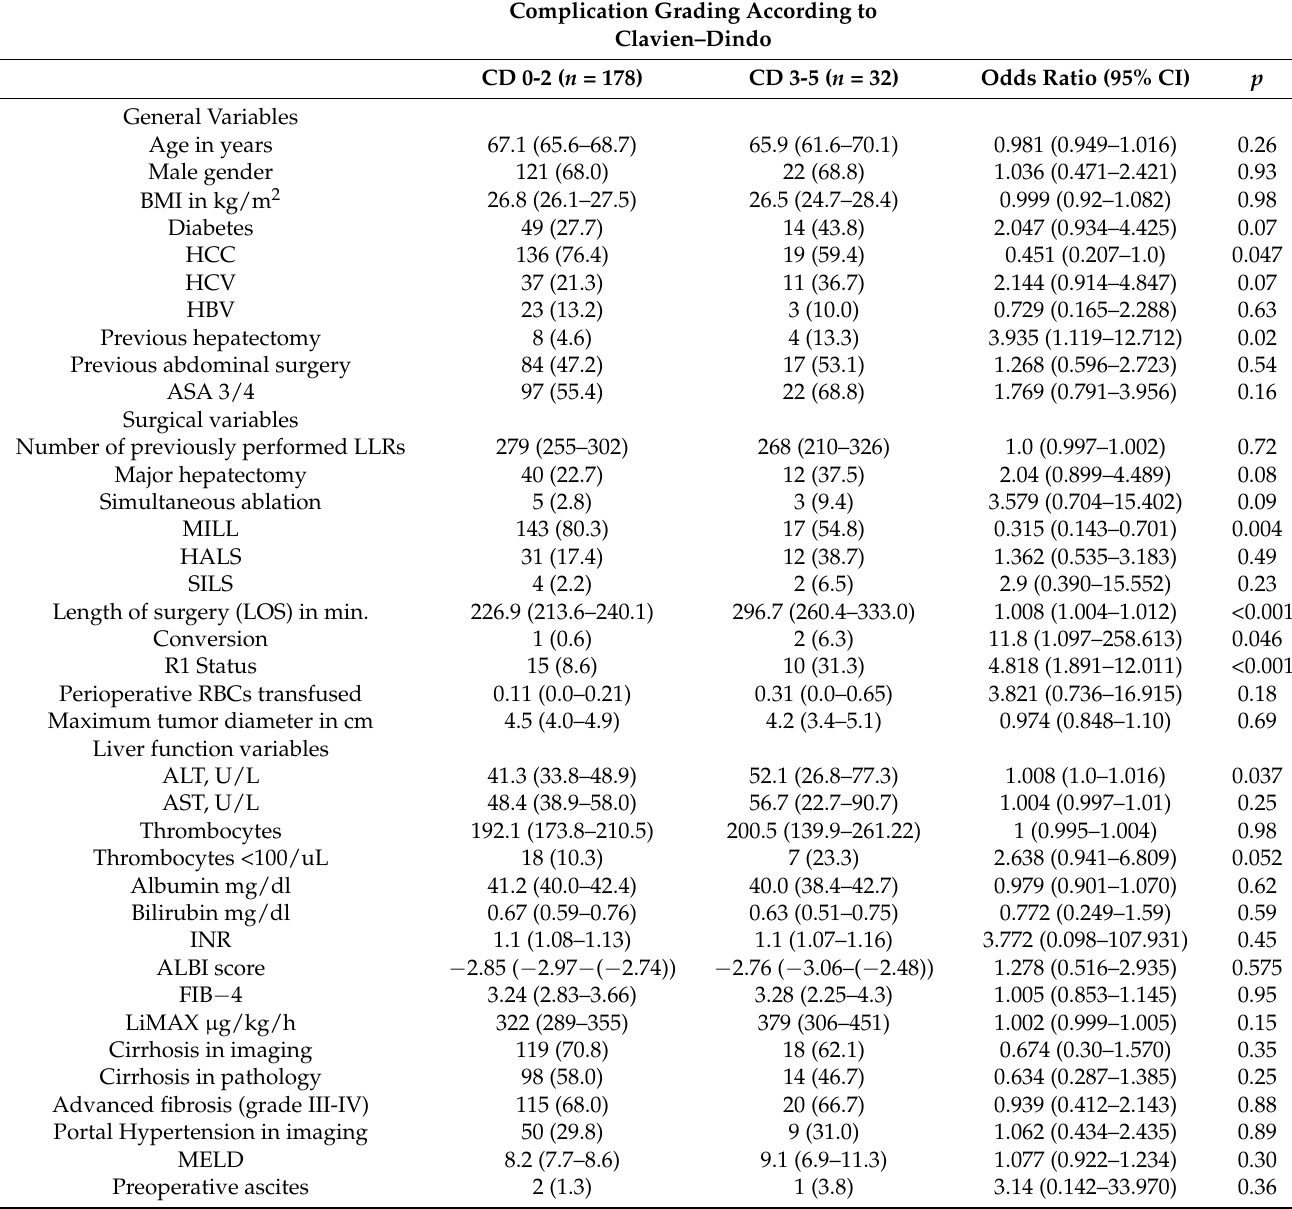
Table 1. Patient characteristics based on the occurrence of major